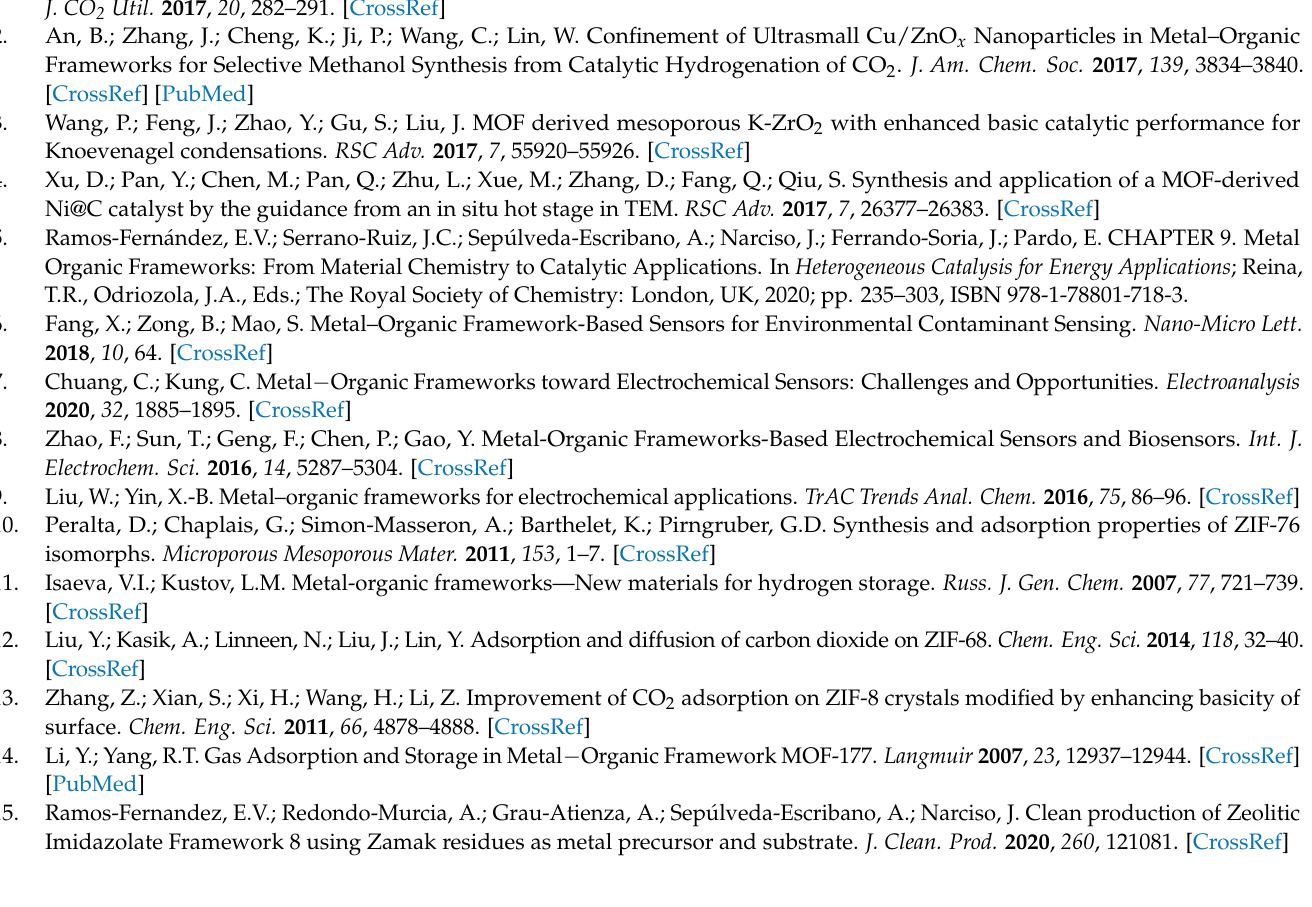
Figure A5. Comparison of the N 2 adsorption isotherm of the samples treated and untreated with NH 4 F